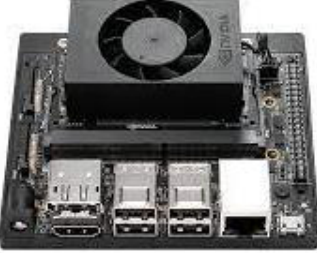
Figure 1. NVIDIA Jetson Xavier [28]